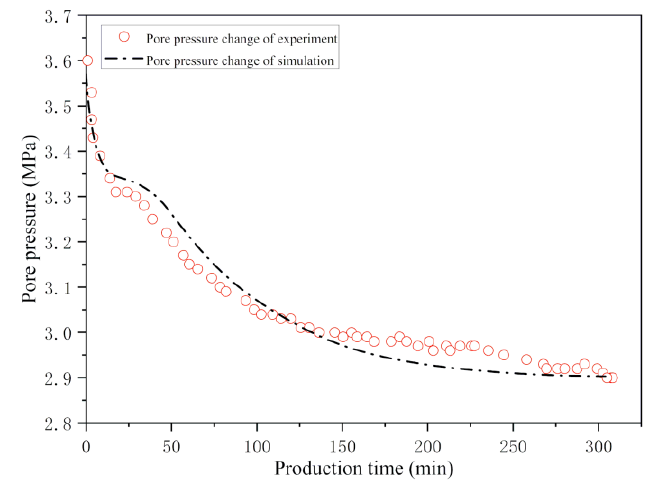
Figure 2. Pore pressure variation with production time compared with Masuda’s experiment.